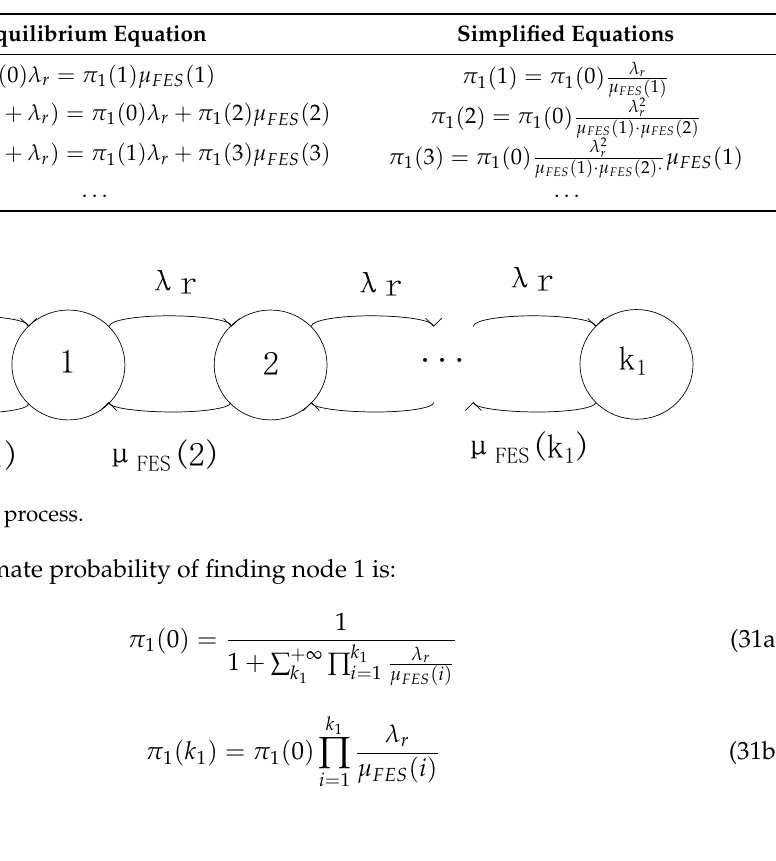
Table 3. Equilibrium equation transfer table.